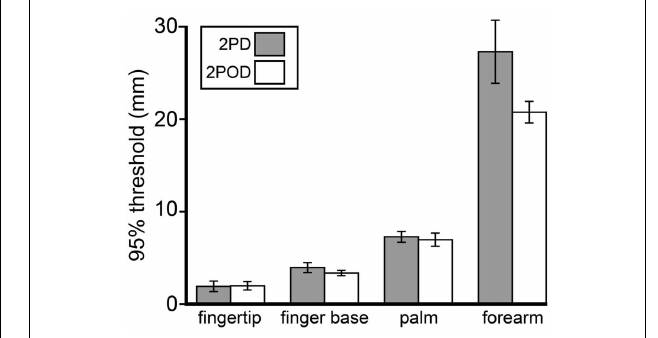
FIGURE 6 | Mean 95%-correct thresholds by task and body site . Gray bars, mean 2PD 95%-correct thresholds; white bars, mean 2POD 95%-correct thresholds. Error bars: ± 1